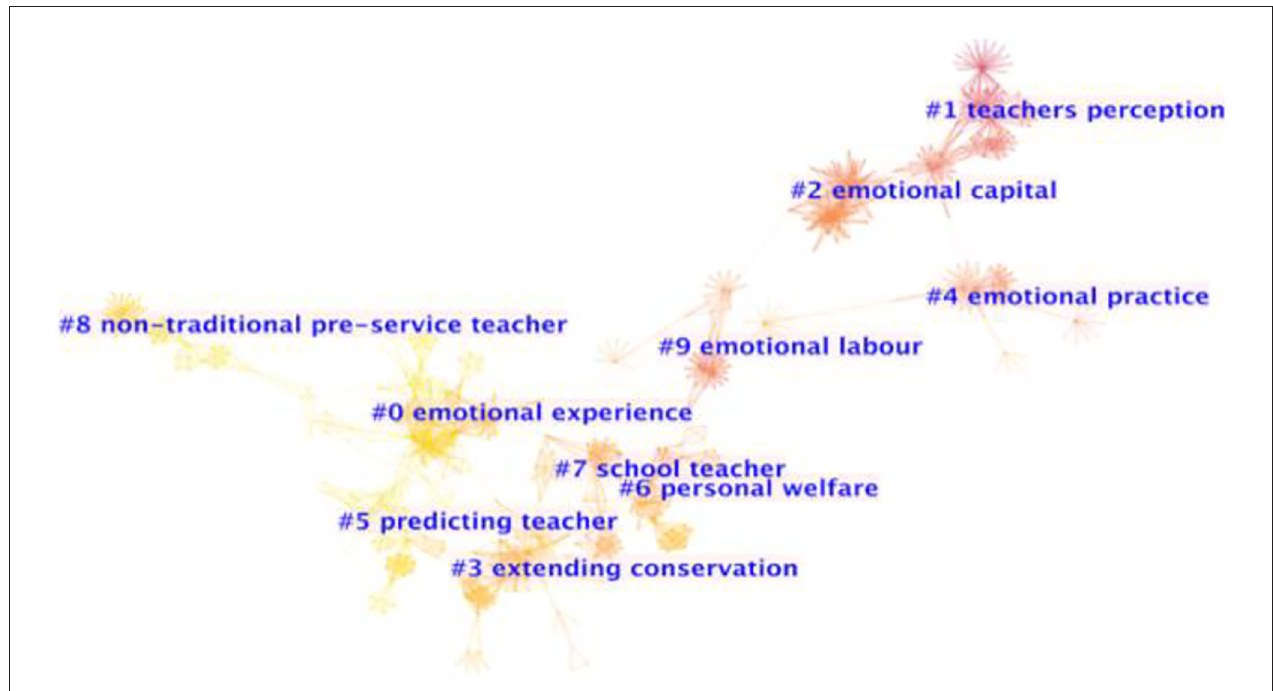
FIGURE 2 | Cluster view of reference co-citation network in TEL documents during